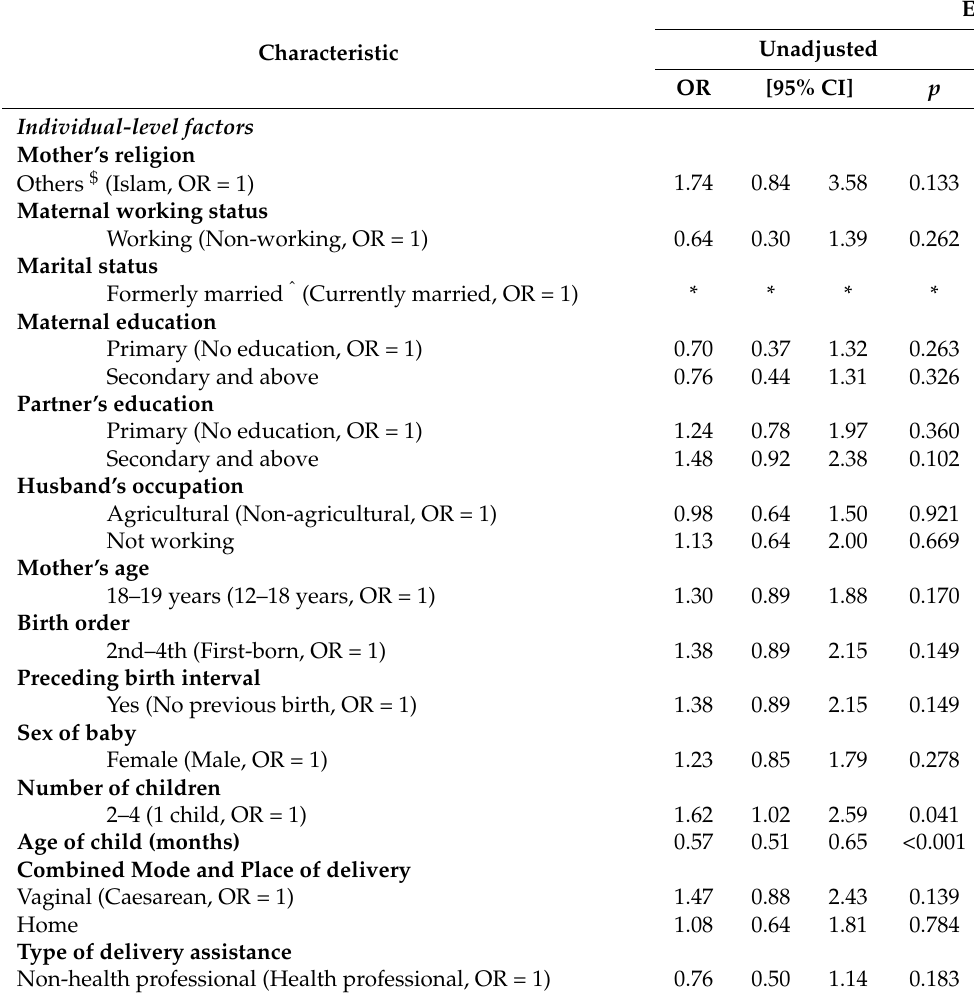
Table 4. Survey logistics modelling of a child being breastfed and predominantly breastfed (PBF)—unadjusted and adjusted Odds Ratios, Bangladesh 2004–2014.